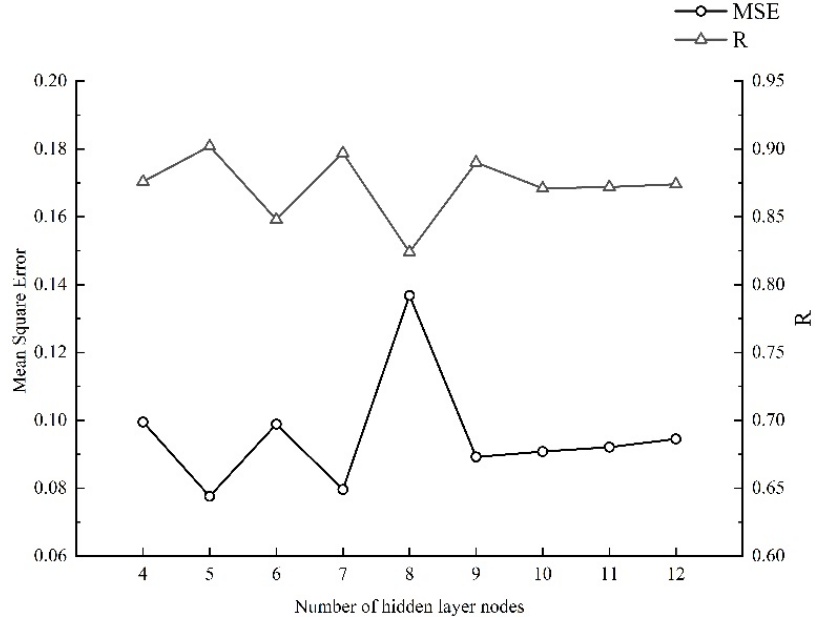
Figure 5. Mean Square Error and R of different hidden layer